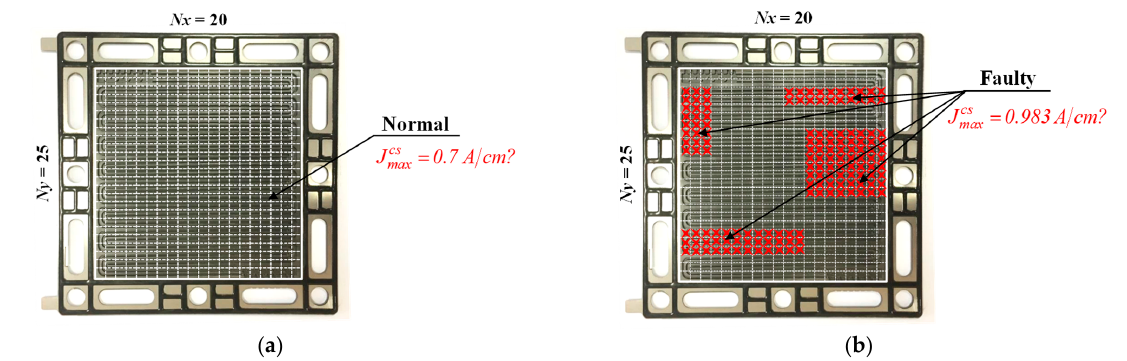
Figure 7. FC representation with a discretization of Ny × Nx = 25 × 20 = 500 conductive segments for: ( a ) a healthy FC, and ( b ) an FC failure.